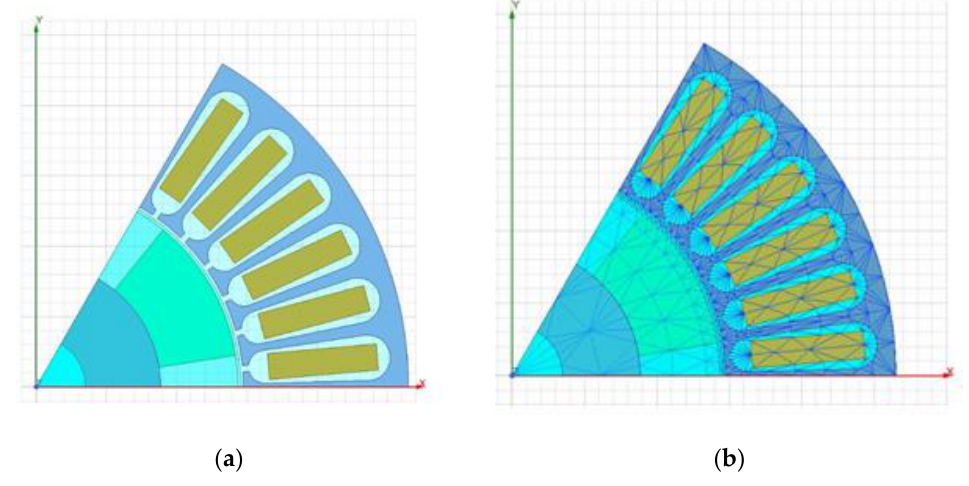
Figure 14. 2D MAXWELL Modeling: ( a ) modeling; ( b ) mesh.